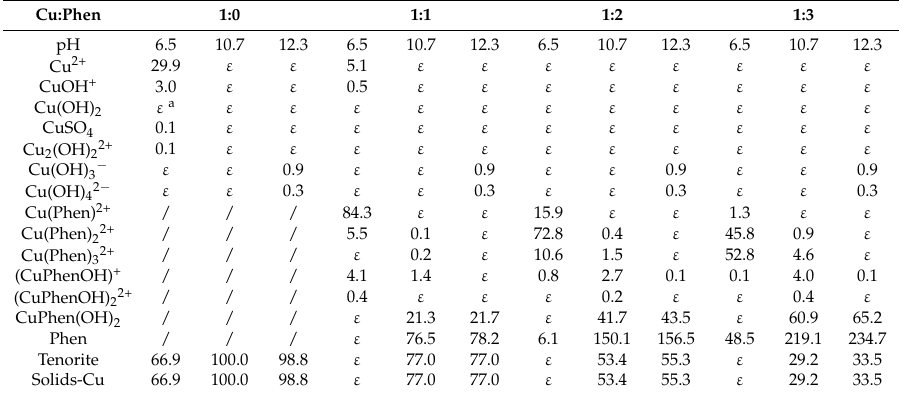
Table 2. Predicted abundances (expressed as percentages of total Cu) of the different species at pH 6.5, 10.7 and 12.3, for Cu:Phen molar ratios = 1:0, 1:1, 1:2 and 1:3, with an initial CuSO 4 concentration of 15 µ M at 25 ◦ C, assuming the occurrence of solids precipitation. The results are given as molar percentages of total [Cu].